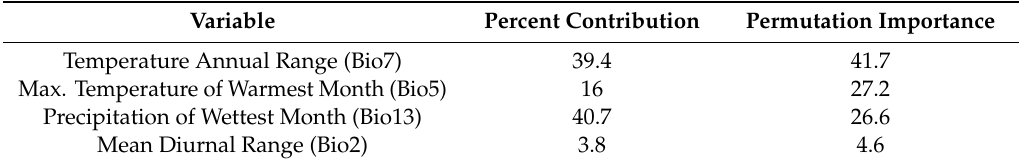
Table 2. Model 1b covariates included in SDM of Ae. albopictus, using all occurrence records of Ae. albopictus distribution in the United States, in order of highest to lowest permutation importance.